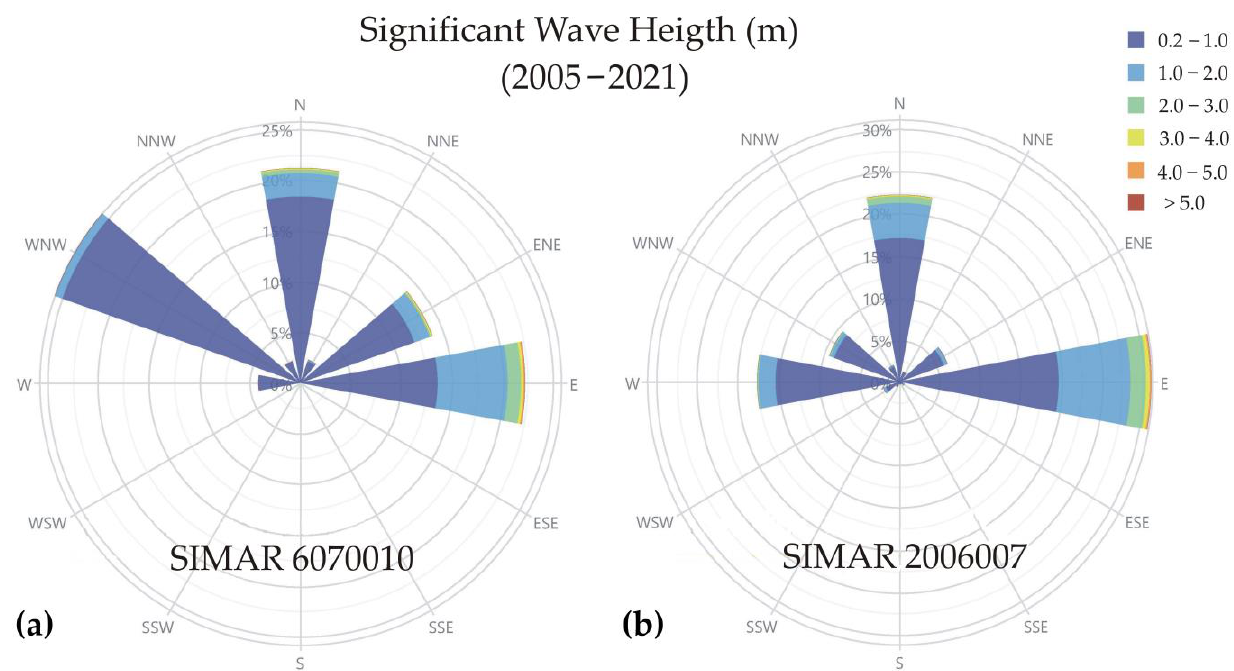
Figure 2. Wave roses for the investigated area (“Puertos del Estado”, www.puertos.es, accessed on 1 March 2020).